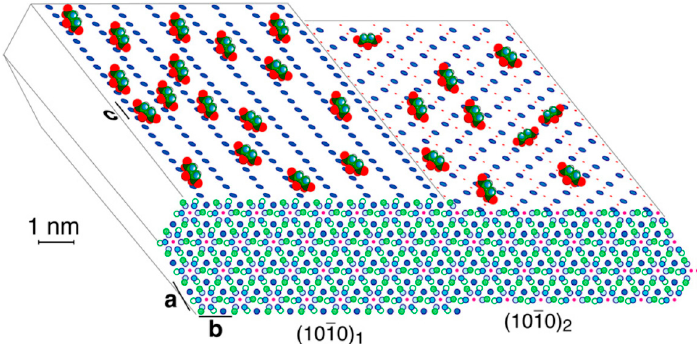
Figure 1. View along the [001] axis of the hexagonal HAp crystal structure. Scheme of apatite-bound citrate (with oxygen of the carboxylates in red) interacting with Ca 2+ on two outmost terminations of the 1010 surfaces, of an idealized bone apatite nanocrystal, at a citrate surface density of ca. 1/(2 nm) 2 . Calcium ions are blue filled circles on top and front surfaces, P is green (omitted on the top surfaces), OH − ions are pink dots, while phosphate oxygen is omitted for clarity. [7]. Figure reprinted with permission from: “Strongly bound citrate stabilizes the apatite nanocrystals in bone” by Hu, Y.Y.; Rawal, A.; Schmidt-Rohr, K. Proc. Natl. Acad. Sci. USA 2010, 107, 22425–22429. Copyright ©